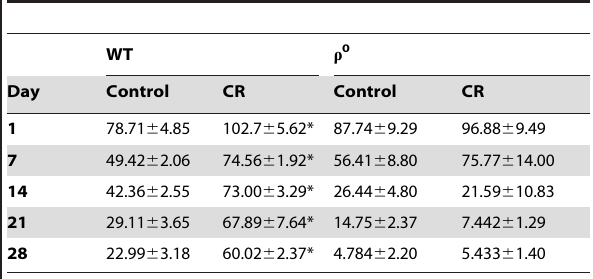
Table 2. Chronological lifespan of WT and r 0 cells cultured under control and CR conditions.